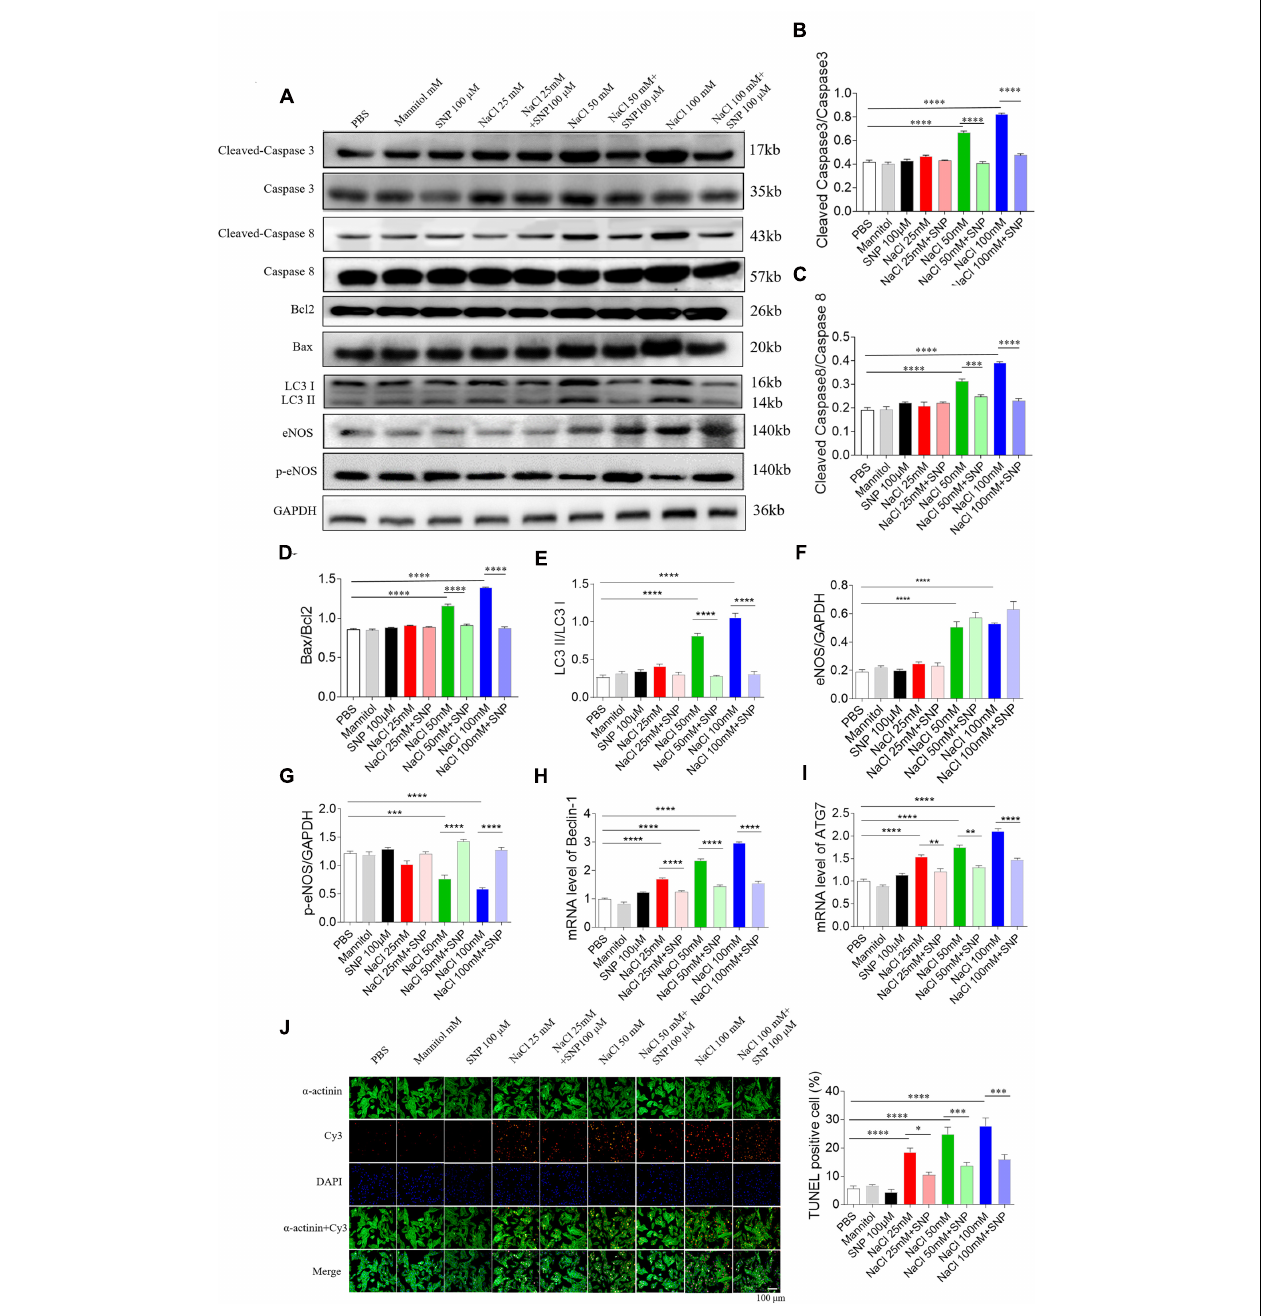
FIGURE 7 | Effects of nitric oxide donor sodium nitroprusside (SNP) on apoptosis and autophagy induced by three doses of sodium chloride (NaCl) in primary neonatal rat cardiomyocytes (NRCM). SNP (100 µ M) attenuated the increases in the levels of cleaved-caspase 3/caspase 3 (A,B) , cleaved-caspase 8/caspase 8 (A,C) , Bax/Bcl2 (A,D) , LC3 II/LC3 I (A,E) , Beclin-1 (H) , and autophagy related 7 (ATG7) (I) , and enhanced the decrease of p-endothelial nitric oxide synthase (eNOS) induced by NaCl (50 or 100 mM) in NRCM (F,G) . The increases of TUNEL-positive cell numbers induced by three doses of NaCl in the NRCM were attenuated by SNP (100 µ M) treatment (J) . The results are expressed as mean ± SEM. * p < 0.05, ** p < 0.01, *** p < 0.001, and **** p <